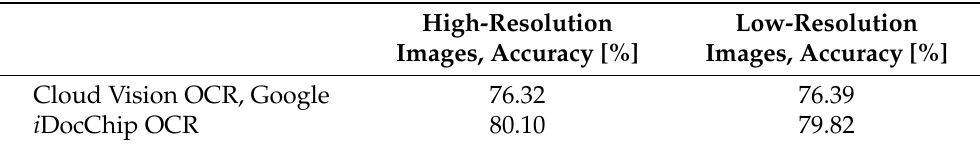
Table 3. Character-level accuracy of Cloud Vision OCR and i DocChip OCR.